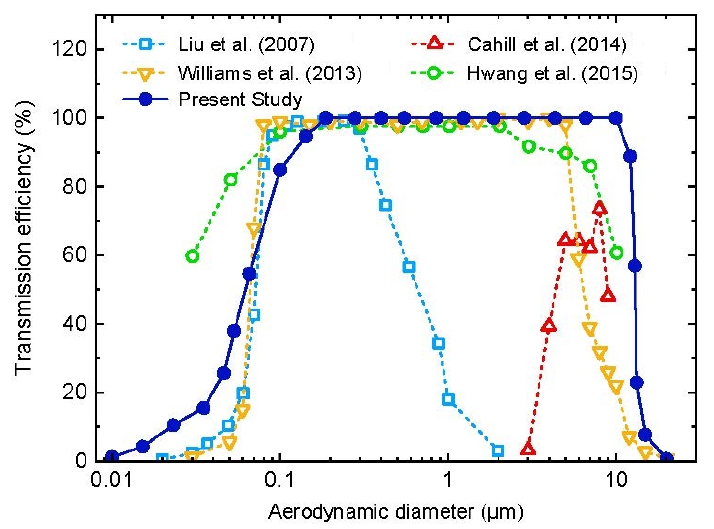
Figure 4. Comparison between theoretical simulated and previously reported transmission efficien- cies of wide-range lens systems [13,20,29,31].